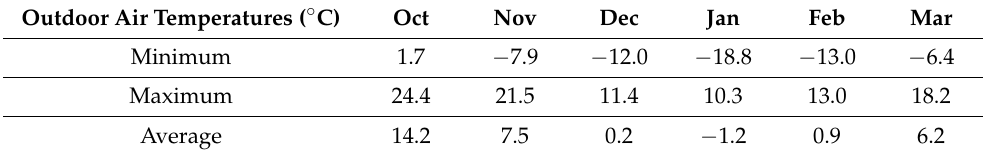
Table 2. Monthly outdoor air temperatures during the simulation period in Daejeon, South Korea. Outdoor Air Temperatures ( ◦